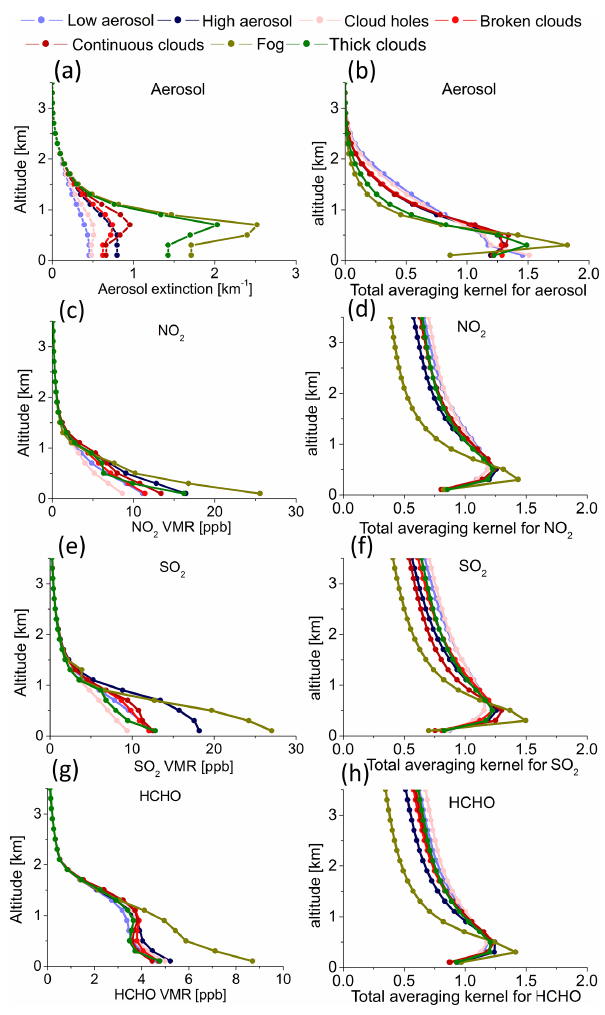
Figure 8. Mean profiles of aerosol extinctions (a) , NO 2 VMRs (c) , SO 2 VMRs (e) and HCHO VMRs (g) from all MAX-DOAS obser- vations under individual sky conditions; (b, d, f, h) show the total averaging kernels of the four species under individual sky condi-